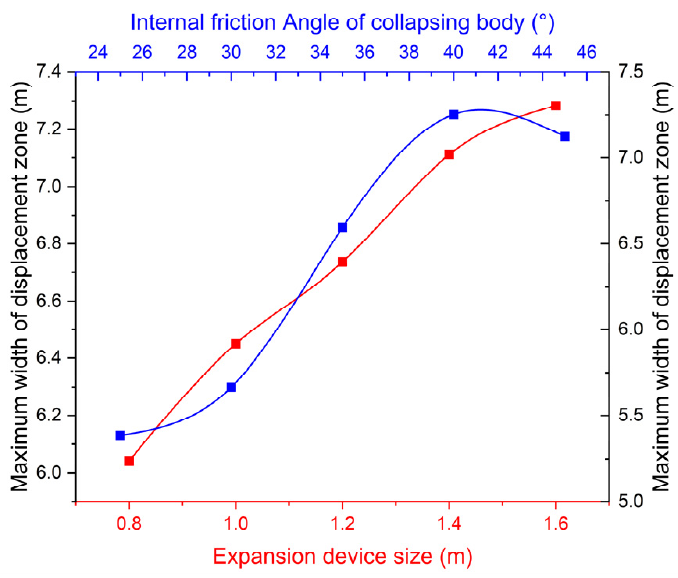
Figure 9. Variation curve of maximum width of displacement region.